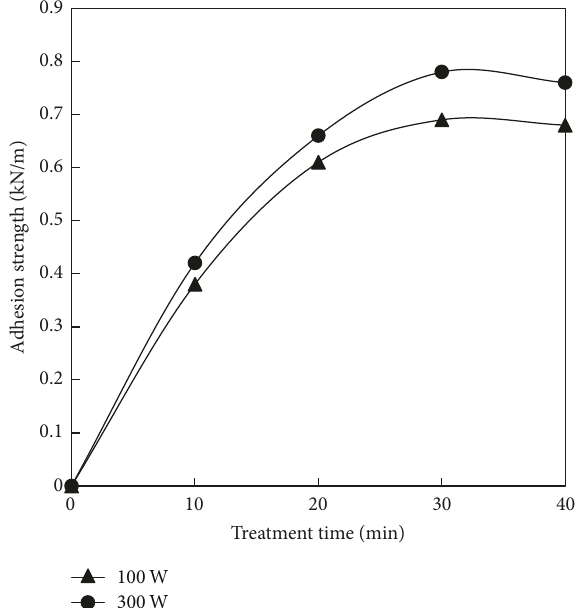
Figure 6: Dependence of the adhesion strength upon the UV power and the treatment time at the TiO 2 content of 1.0g/L.